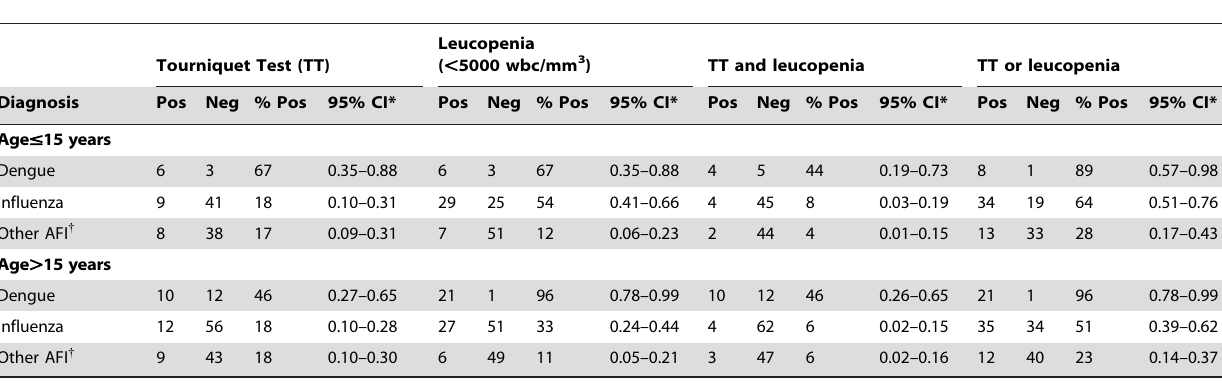
Table 2. Tourniquet test and leucopenia as diagnostics markers among patients by age group.